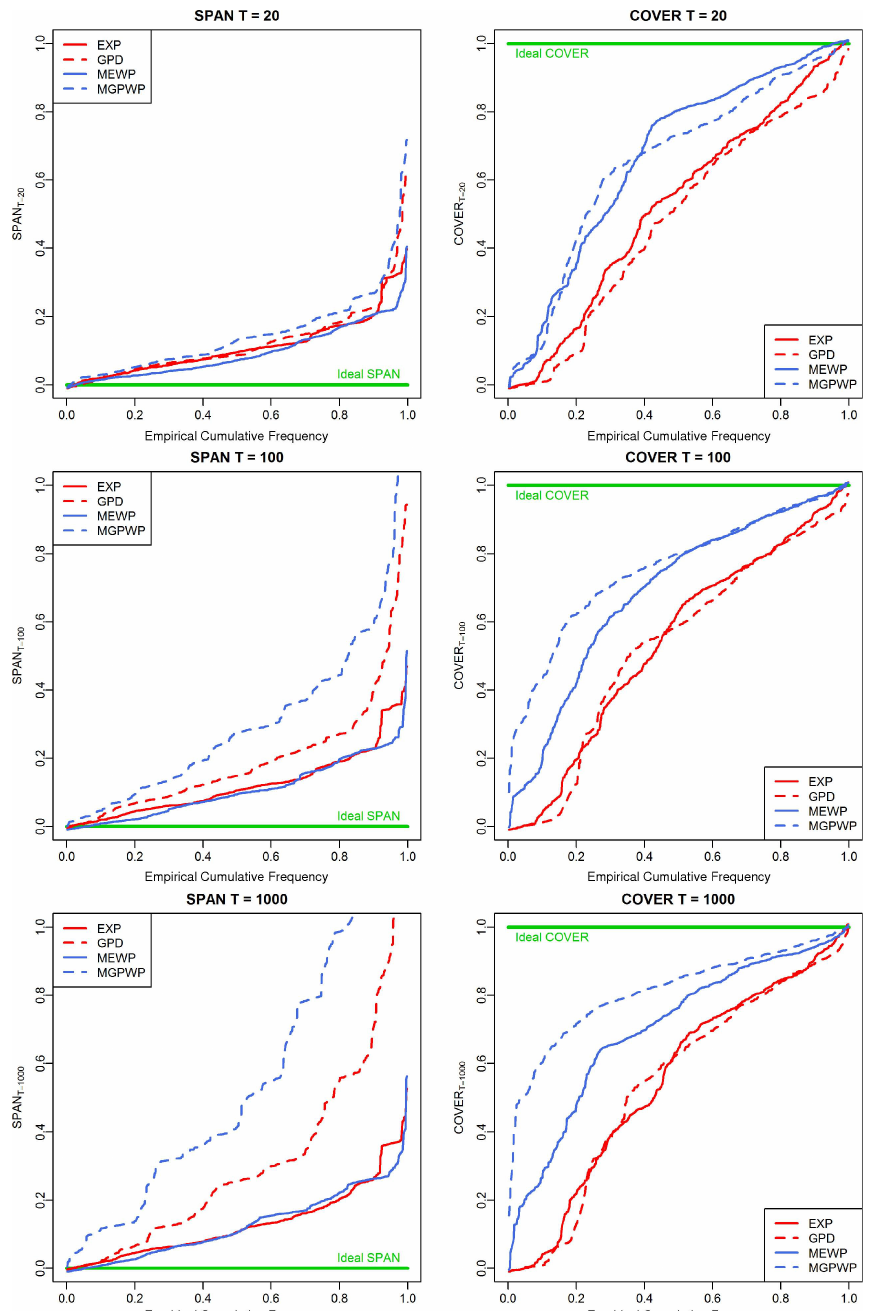
Fig. 8. Empirical distribution of SPAN T and COVER T criteria at 20-years, 100-years and 1000-years return levels. Whole dataset is used to computed these